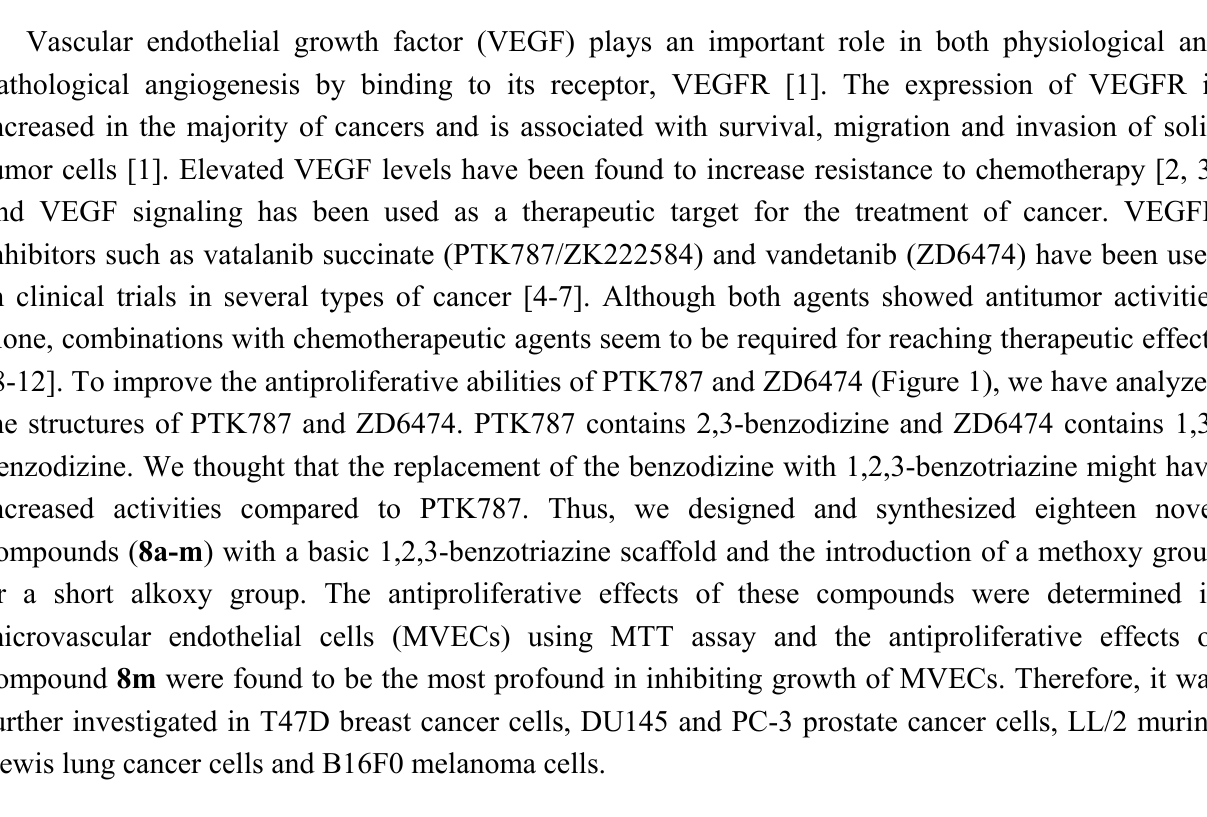
Figure 1 . Structures of vatalanib succinate (PTK787) and vandetanib